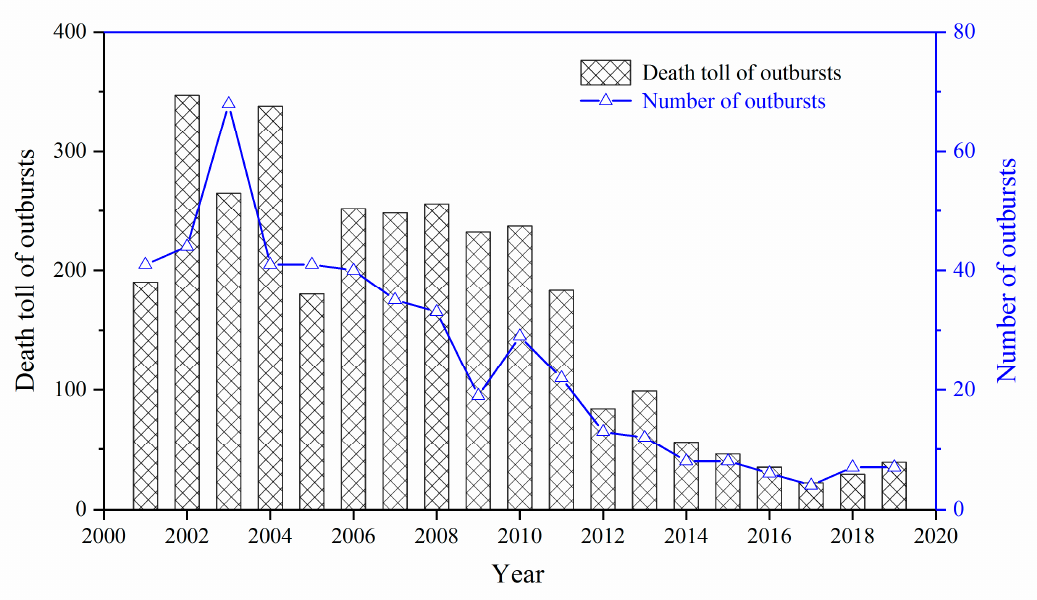
Figure 1. Death toll and number of outburst accidents from 2001 to 2019 in China.